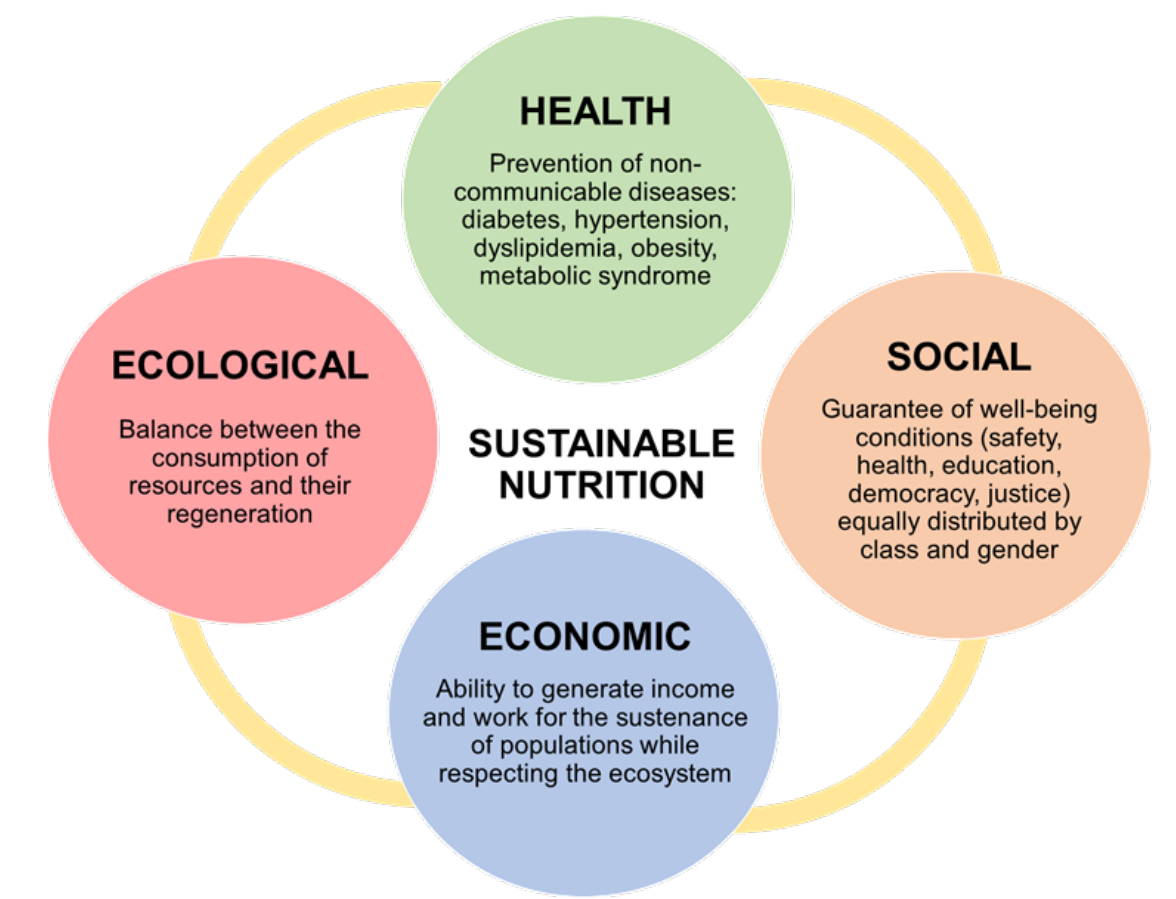
Figure 1. Characteristics of sustainable nutrition in the various areas.